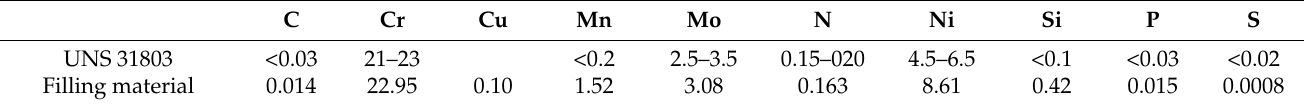
Table 3. Nominal chemical composition of the UNS 31803 steel and filling material